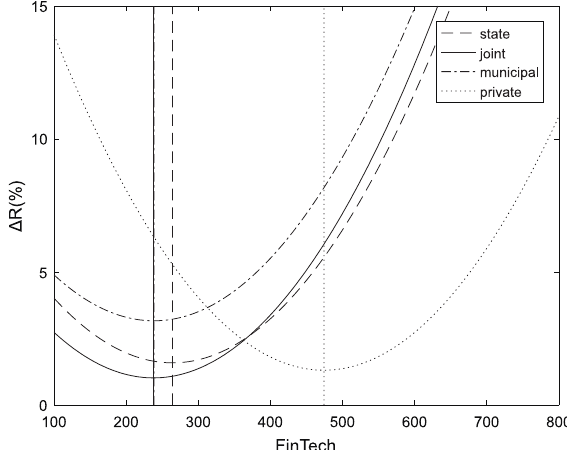
Figure 4. The fitted parabolas for the empirical results in Column (1) of Table